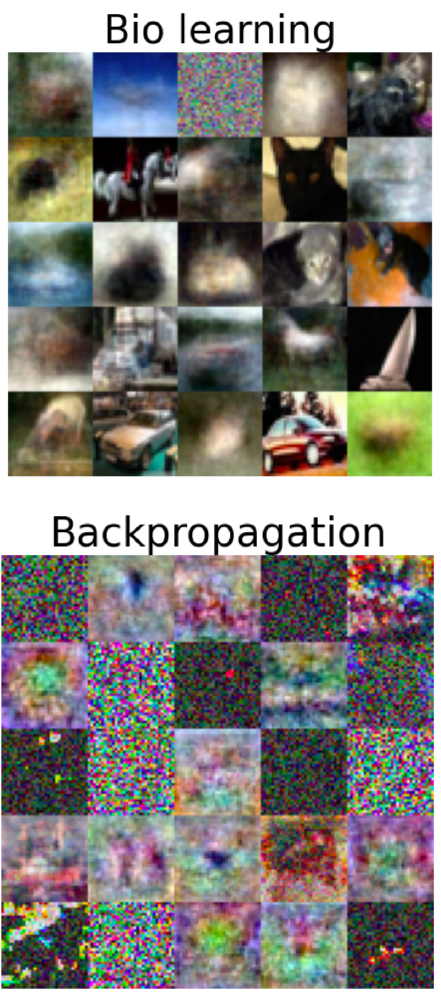
Figure 2. Shown are 25 randomly selected feature detectors for CIFAR-10 classification out of 2000. On the top are the weights learned by the biologically plausible model’s unsupervised learning component; on the bottom are the weights learnt by the classic neural network model using end-to- end